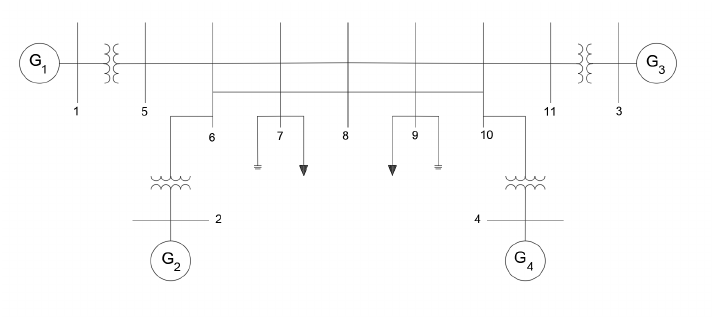
Figure 3. Two area system.